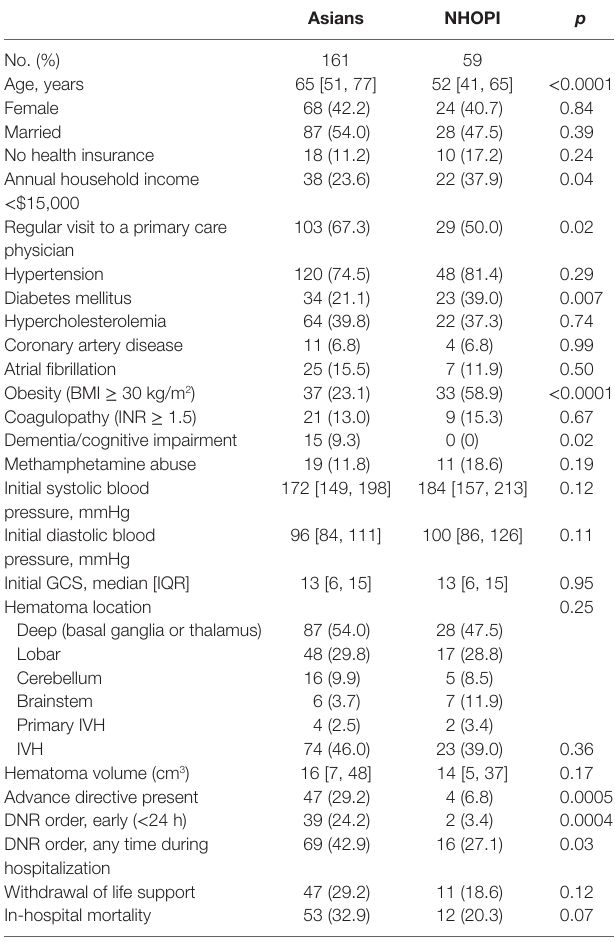
TaBle 1 | Comparison of characteristics between Asians and